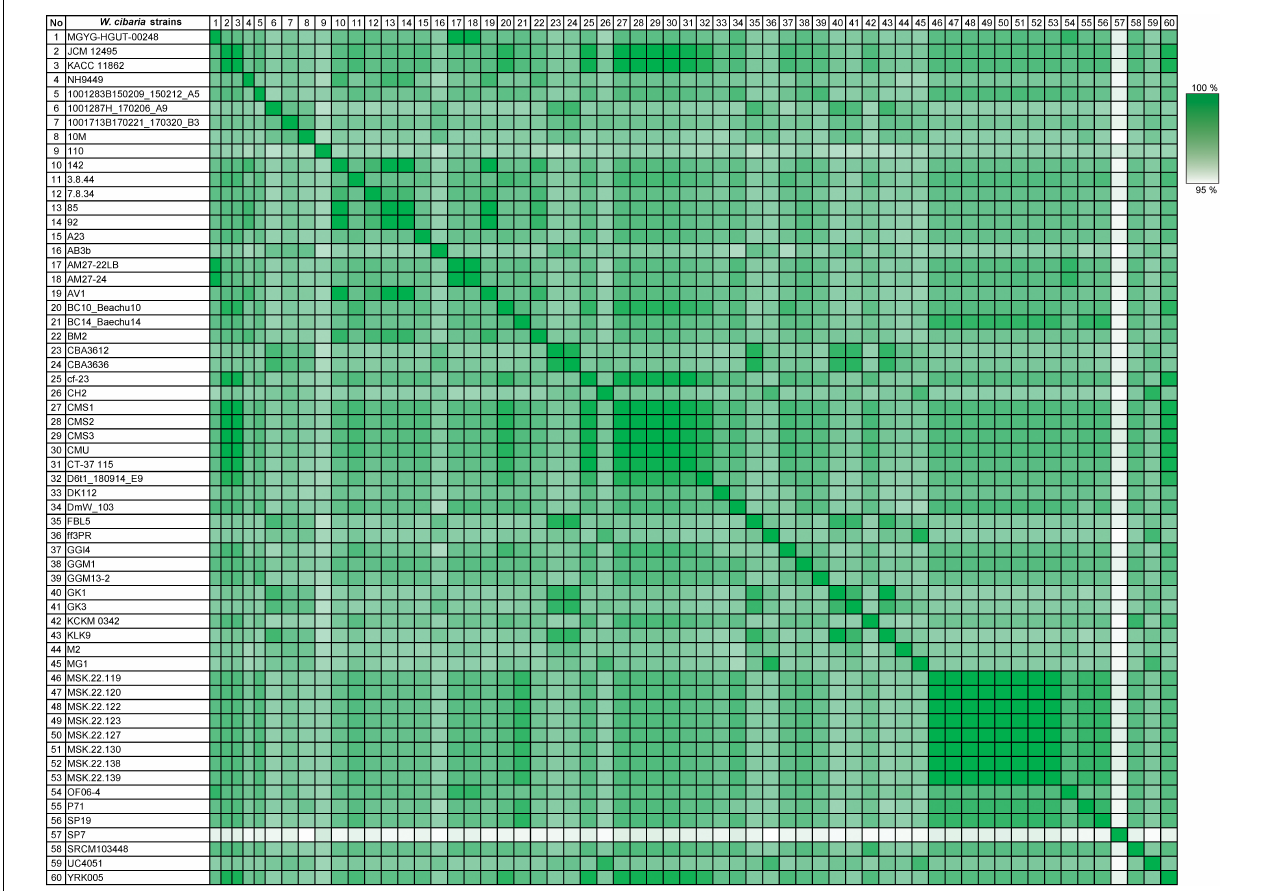
FIGURE 4 | Average amino acid identity analysis of 60 W. cibaria strains. The numbers display the percentage similarity between W. cibaria strains, where the colors vary from white (low similarity) to green (high